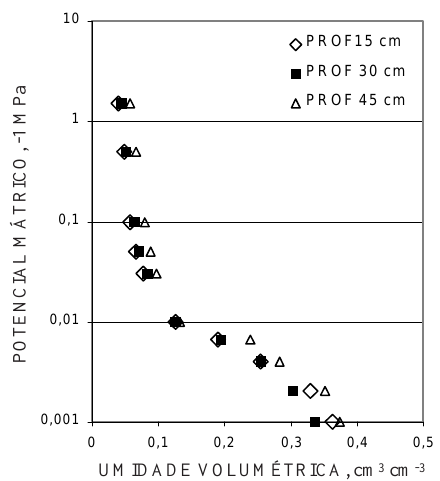
Figura 2. Curva de retenção de água no